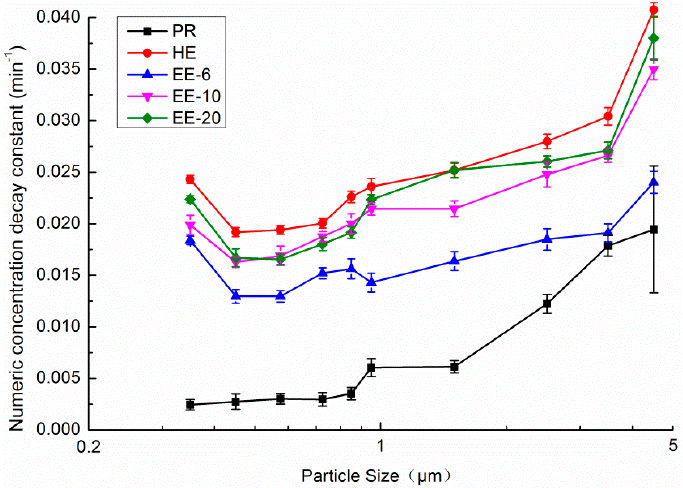
Figure 12. Size-resolved numeric concentration decay constant over 1 h for PACs with different single filters.